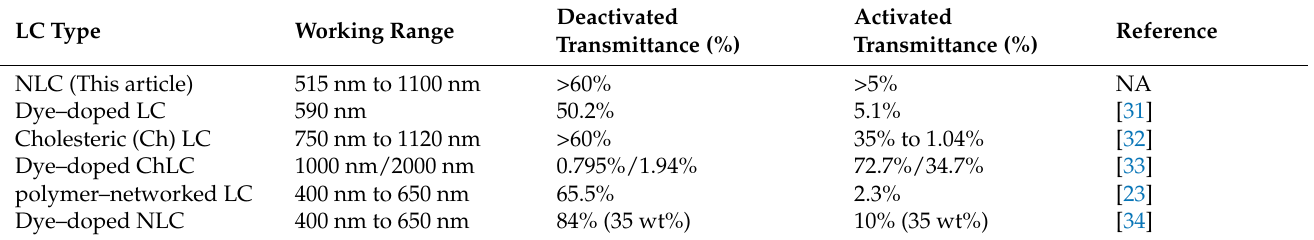
Table 1. Summary of the NLC shutter performance as compared with for other reported LC